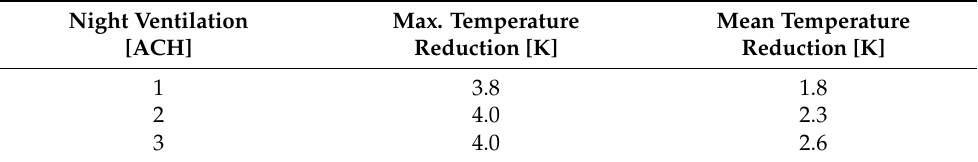
Table 2. Influence of different intensities of night ventilation on room temperature. Temperature reductions compared to simulation without night ventilation are given.